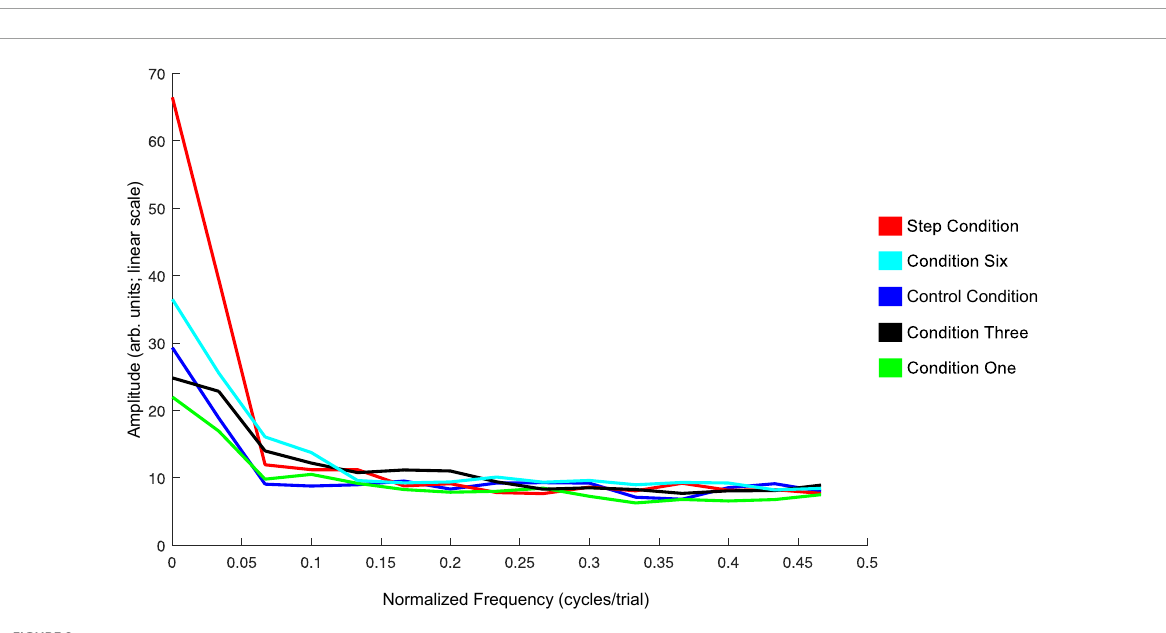
FIGURE9 Average amplitude spectra across all 20 speakers for the Step Condition (red), Condition Six (cyan), Control Condition (blue), Condition Three (black), and Condition One (green) in Experiment 2. The left-most frequency bin of 0 cycles/trial represents the DC-offset. It reflects the mean change in normalized F1 values in the Perturbation phase of each condition as compared to Baseline. Instances of peaks in amplitude at higher frequencies would represent prominent oscillation of F1 values across trials in the Perturbation phase. The spectra were created using a discrete Fourier transform with a Hanning window and sampling frequency set to one sample per